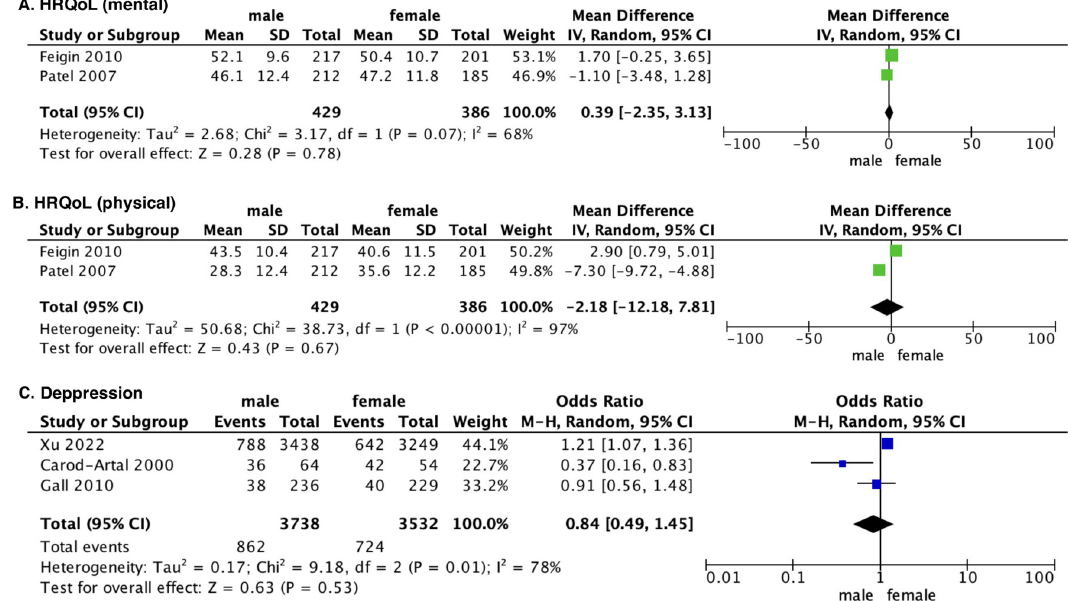
Fig 3. Forest plot showing secondary outcomes between males and females. M-H: Mantel-Haenszel statistic.